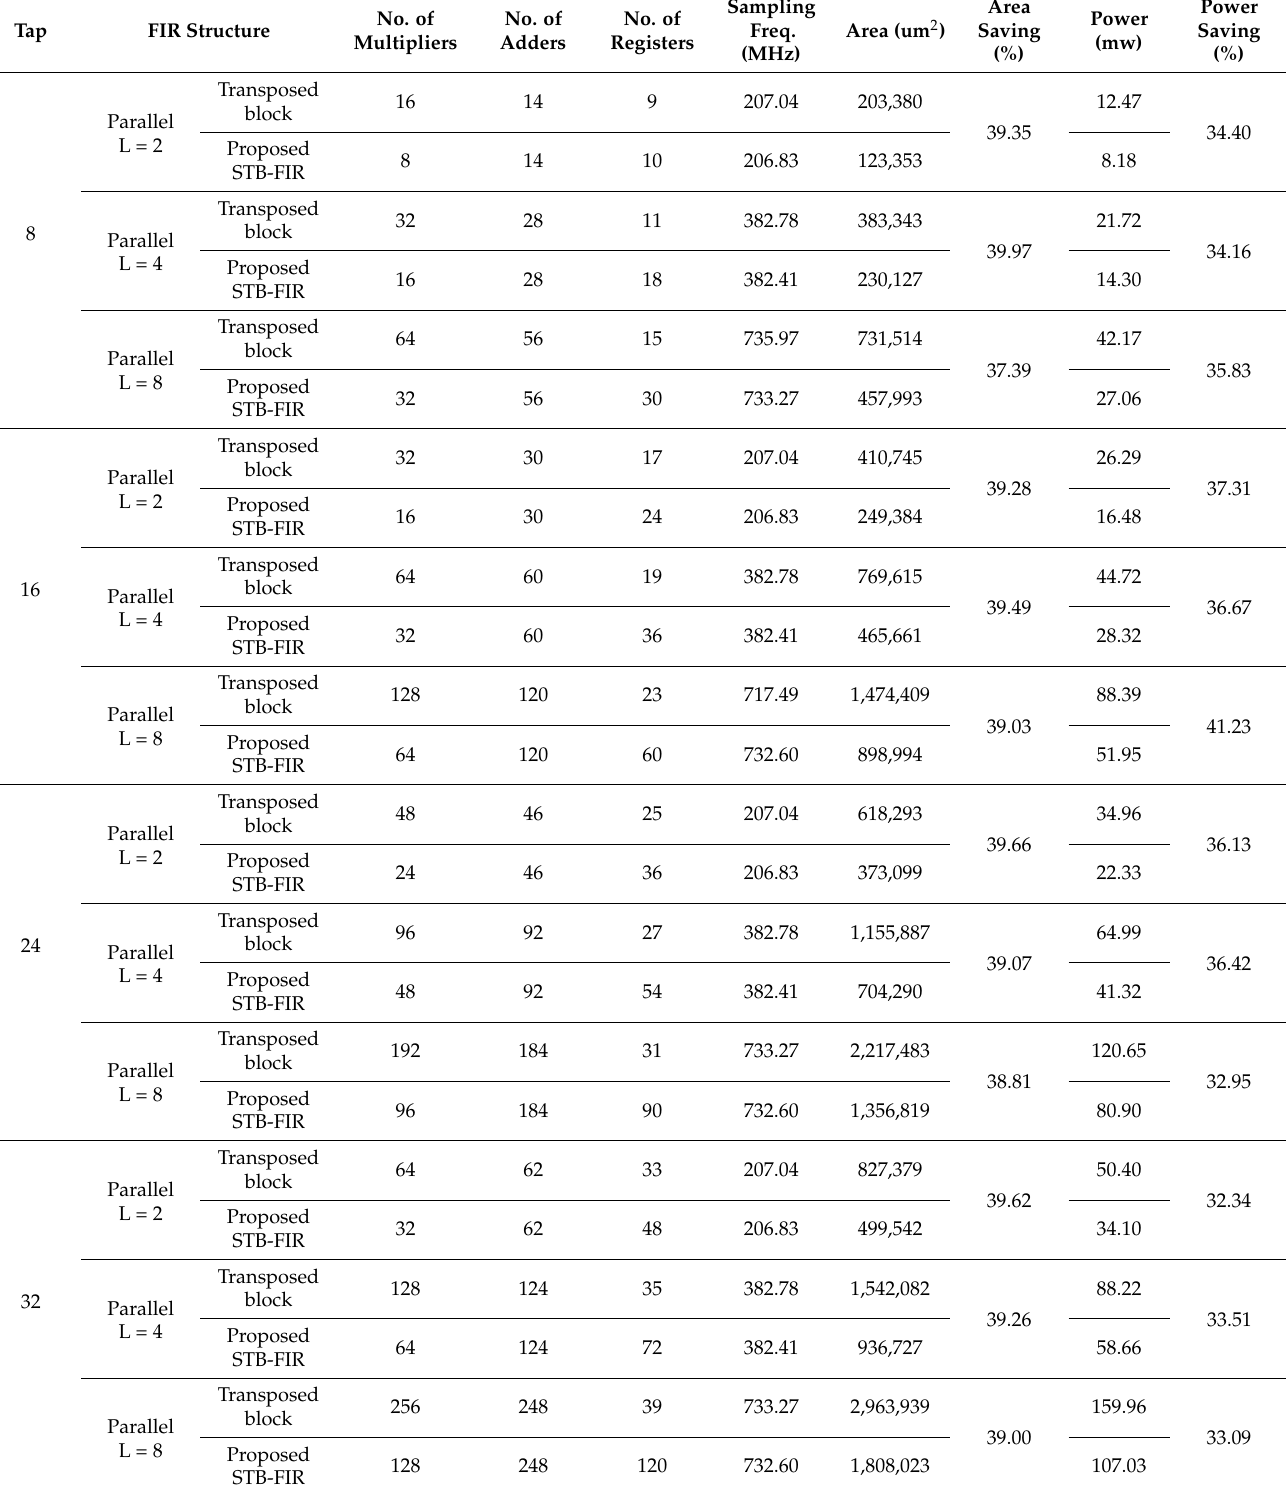
Table 2. Comparisons of various parallel FIR